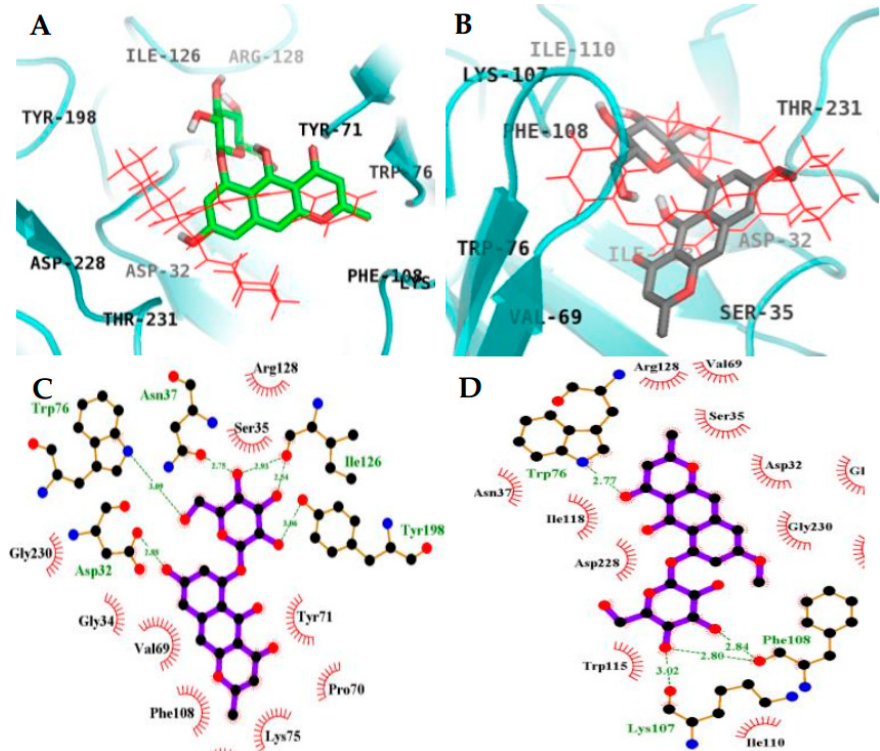
Figure 7. Inhibition mode of 4 ( A ) and 2 ( B ) for the BACE1 catalytic site with 2-amino-3-{(1 R )-1-cyclohexyl-2-[(cyclohexylcarbonyl) amino]ethyl}-6-phenoxyquinazolin-3-ium (QUD) (red line) ( A ). 2D ligand interaction diagrams of BACE1 catalytic inhibition by 4 ( C ) and 2 ( D ). Dashed green lines indicate H-bonds. Carbons are in black, nitrogens in blue, and oxygens in red.